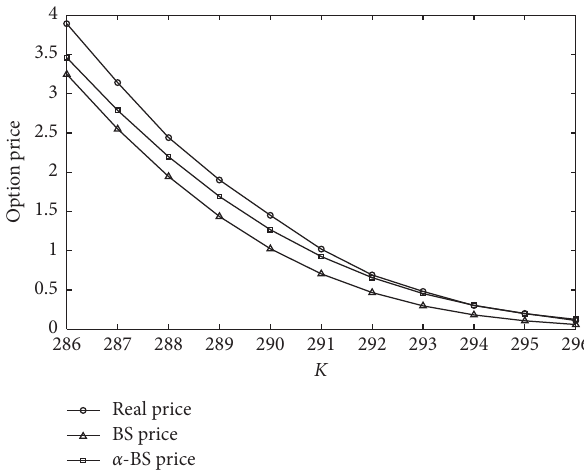
Figure 2: The call option price with different α . Here, r � 0 . 05, σ � 0 . 8, S t � 10, T � 2, and t �